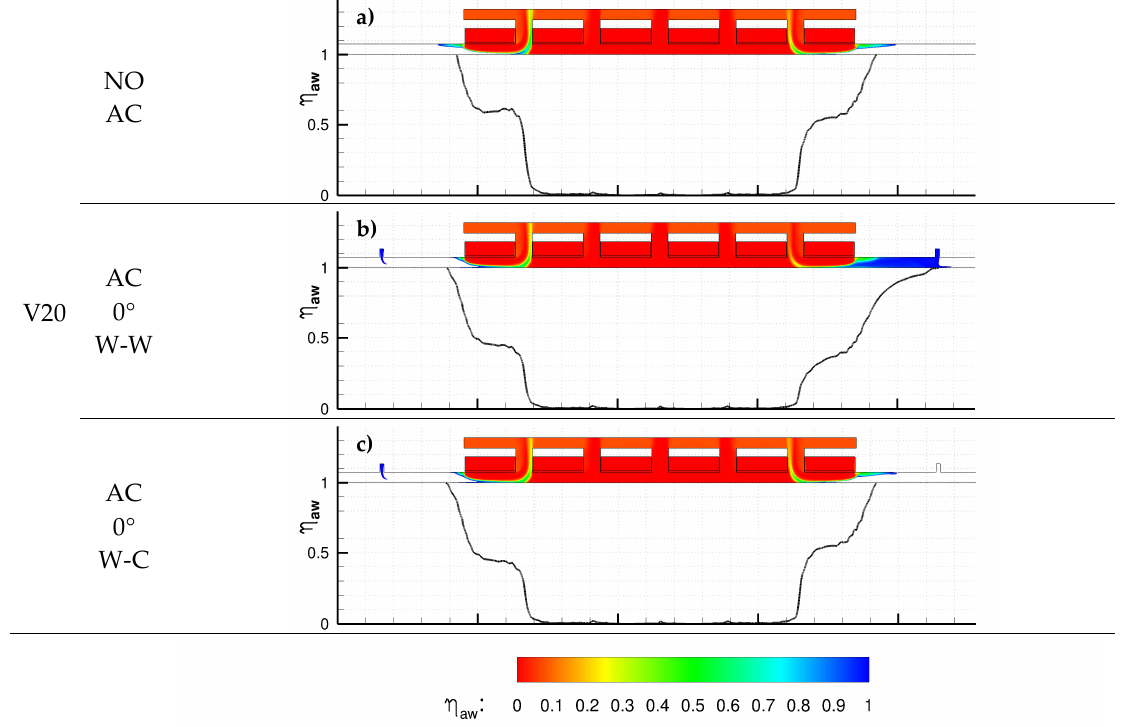
Figure 17 . Adiabatic wall effectiveness coefficient distribution for the reference configuration without air curtains and the best configuration with warm air curtains, at 20 m/min fabric speed.